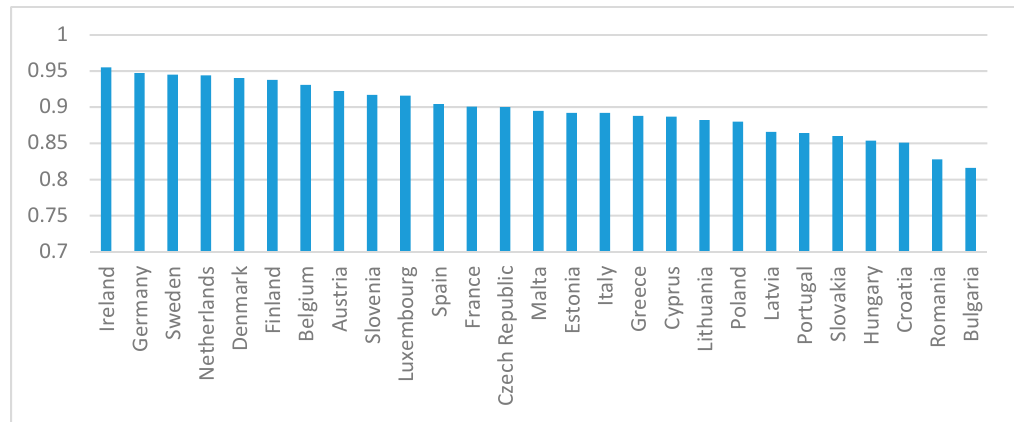
Figure 6. Human Development Index in European Union countries, 2019. Source: Authors’ processings based on Human Development Report 2019 (http://hdr.undp.org, accessed on 1 February 2021).